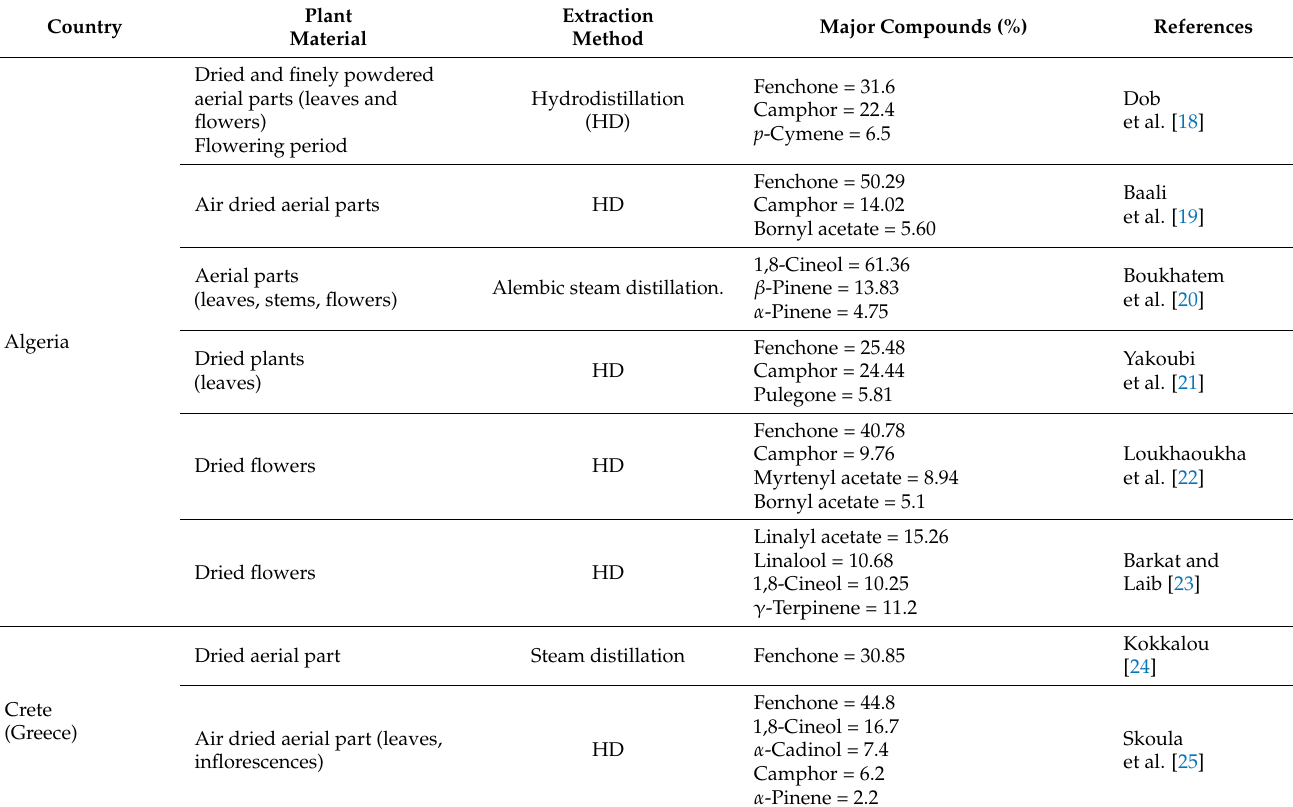
Figure 2. GC-MS chromatogram obtained from Lavandula stoechas essential oil. The chemical composition of EOLS varies from that of many other Lavandula species and hybrids found in the Mediterranean region. The primary constituents of EOLS are oxygenated monoterpenes such as linalool, camphor, 1,8-cineol, terpineol, linalyl acetate and terpinene-4-ol. The chemical composition of EOLS has been investigated in various Mediterranean countries (Algeria, Greece, France, Tunisia, Italy, and Turkey), with varying results (Table 3). Table 3. Major chemical compounds EOLS from different regions.